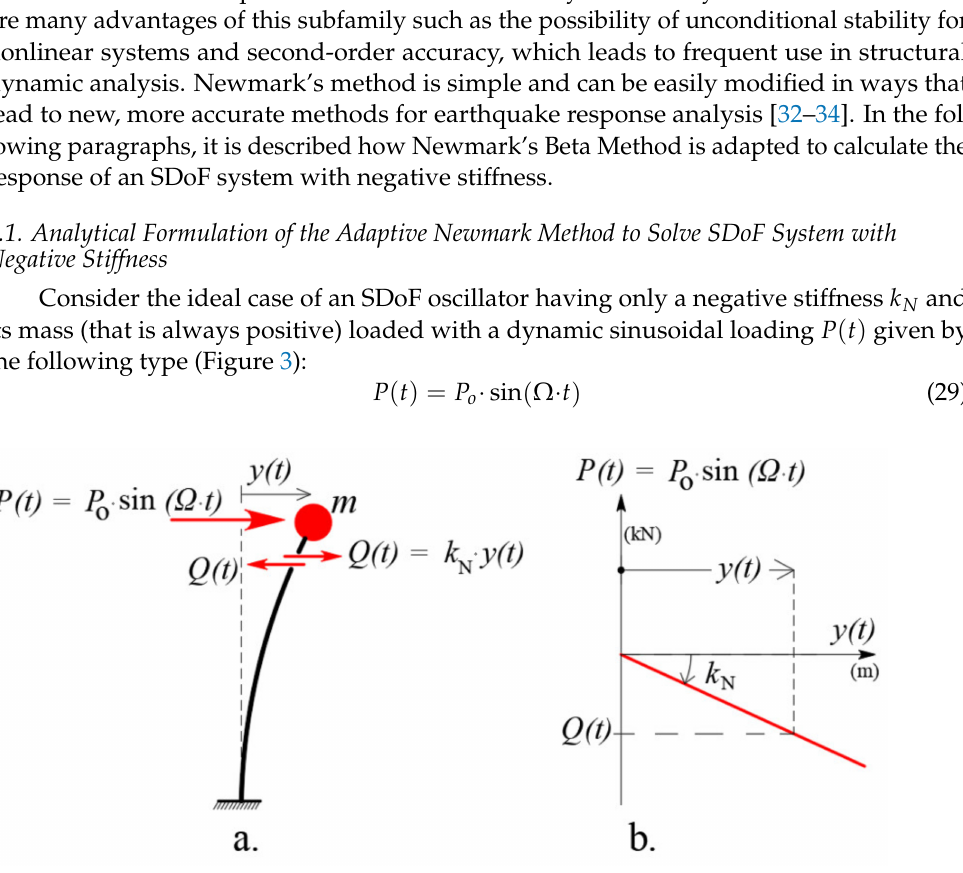
Figure 3. ( a ) Harmonic loading of an ideal SDoF oscillator with negative stiffness; ( b ) negative